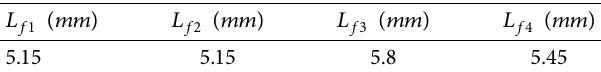
Table 9: Dimension of feed lines for design 10dB ATRD coupler has been described in Example 3.